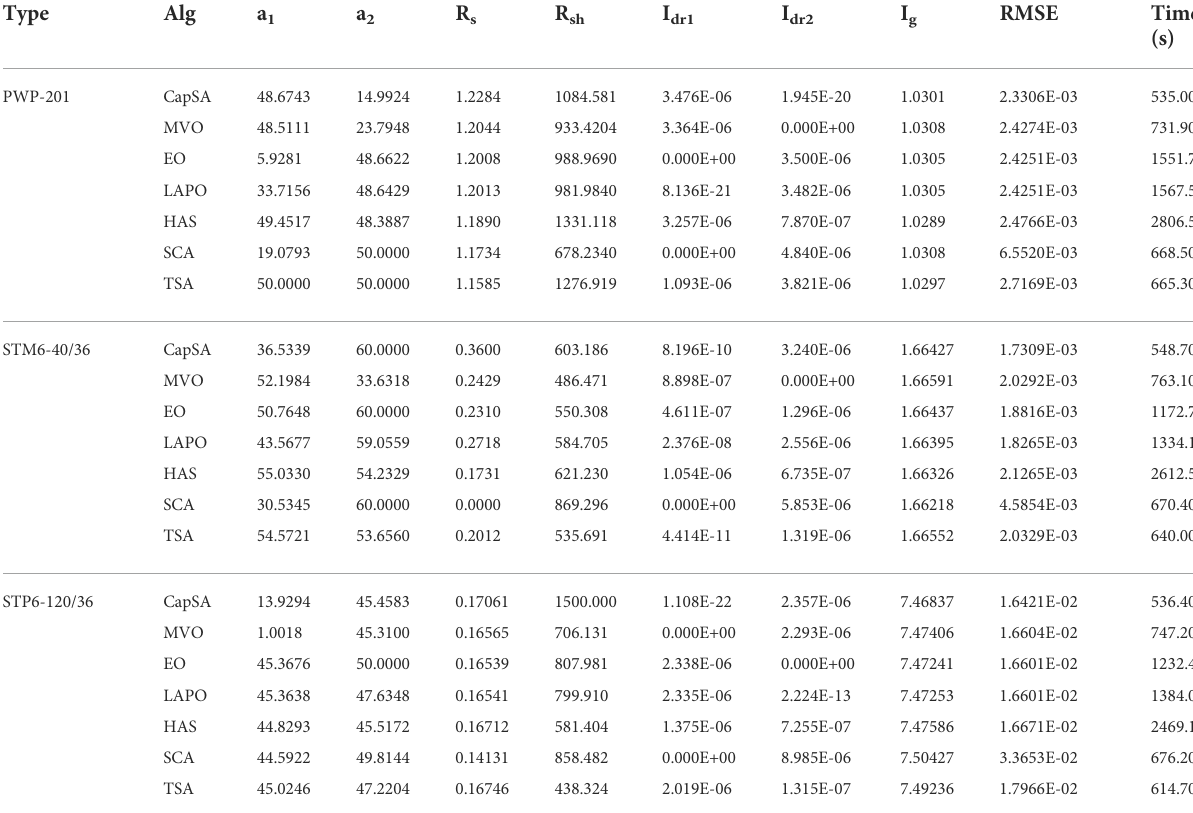
TABLE 7 DDM optimal parameters of PWP-201, STM6-40/36, and STP6-120/36